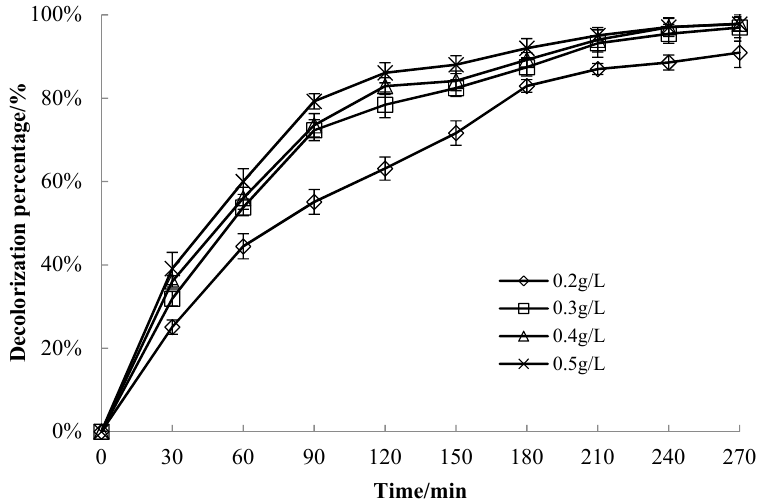
Figure 5. Effect of catalyst dosage on the degradation efficiency of the MB solution.